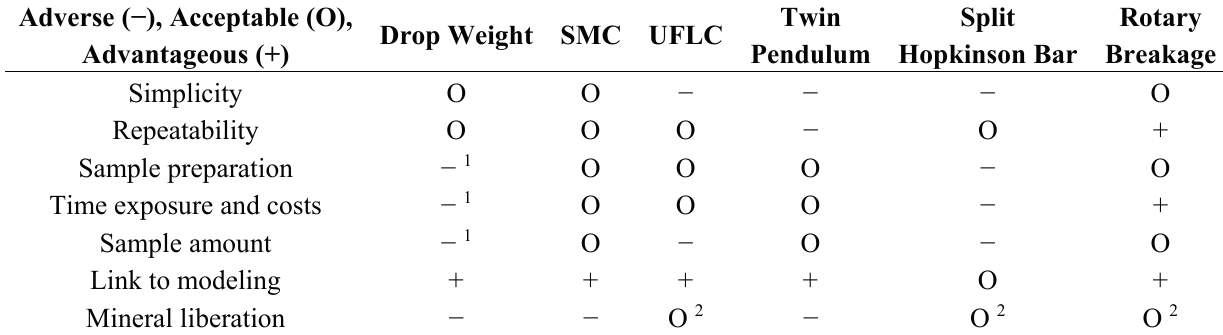
Table 2. Particle breakage